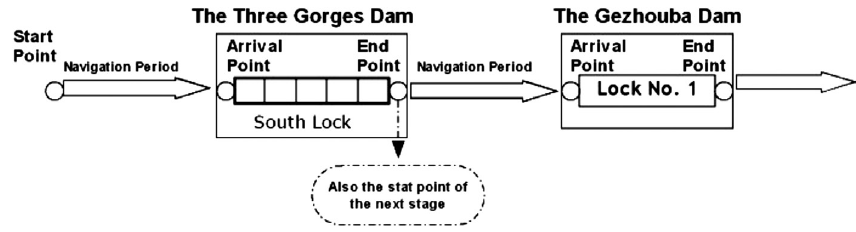
Fig. 2. An example of the navigation route (a ship from upriver)